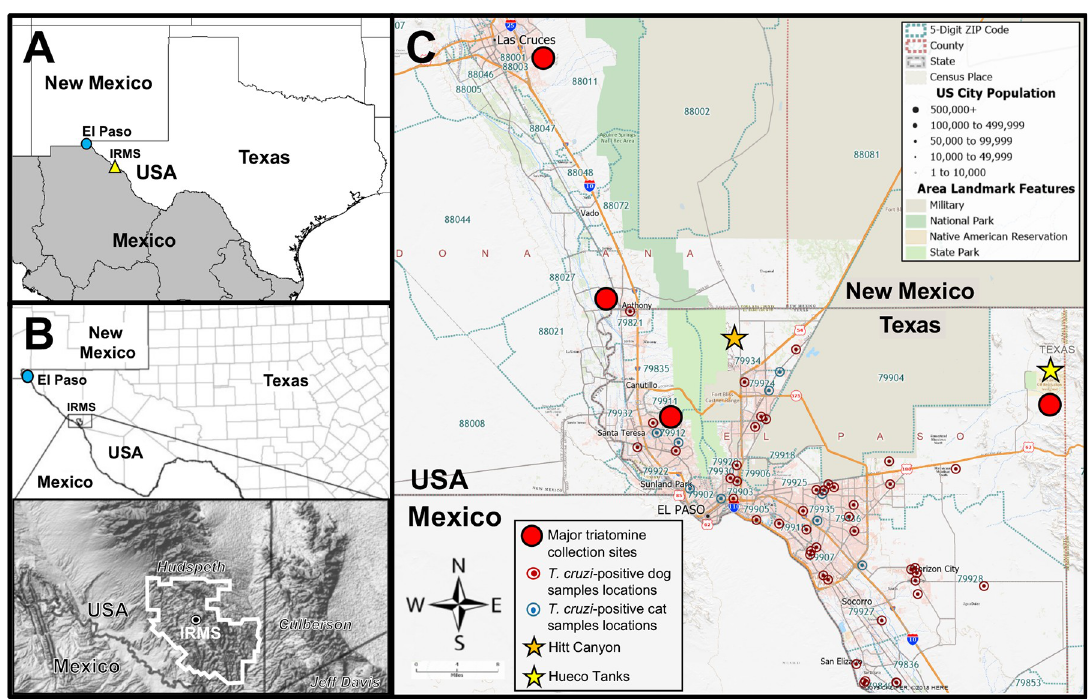
Fig 1. Sample collection sites in El Paso County and surrounding areas in Texas and New Mexico. ( A ) Major triatomine collection sites in or nearby El Paso County (blue circle) and at IRMS, TX (yellow triangle). ( B ) Detailed location and map of IMRS, TX. Inset: IRMS laboratory (encircled black dot) and the field station entire area (white line) are indicated. ( C ) Detailed map of distribution of collected samples in El Paso County, TX, and nearby areas in New Mexico (cities of Anthony and Las Cruces). Maps sourced from the U.S. Geological Survey (https://www.usgs.gov/) and generated with Maptitude 2019 (Caliper Software) and DIVA-GIS 7.5 (https://www.